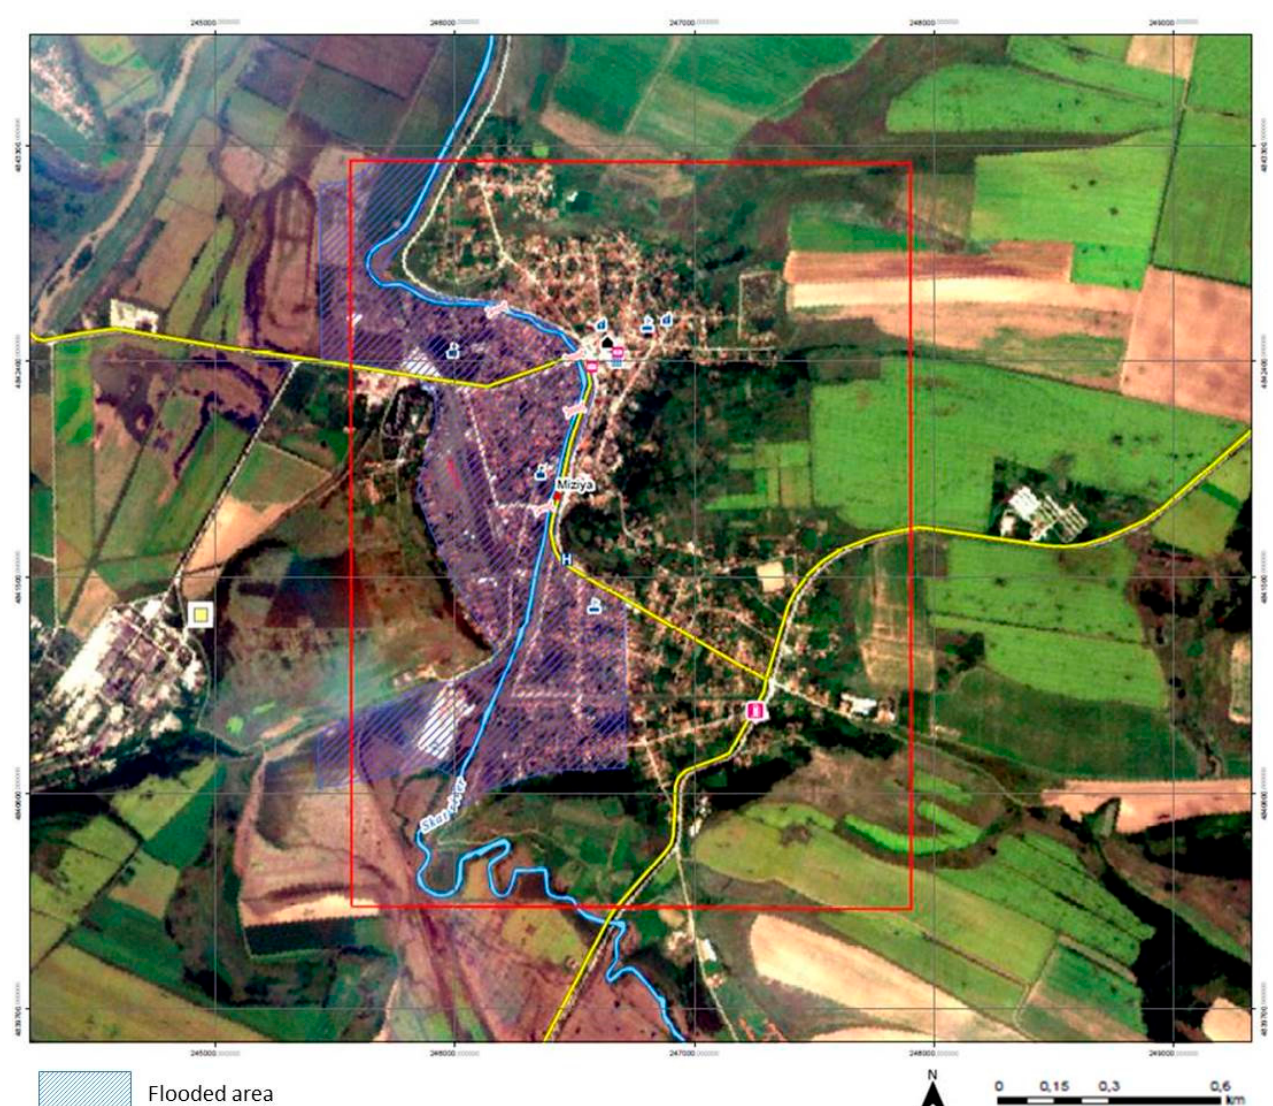
Figure 3. Evaluation of the flooded critical infrastructure elements map, Miziya, Vratsa District, Bulgaria, uploaded on the Copernicus Risk Relay Portal.